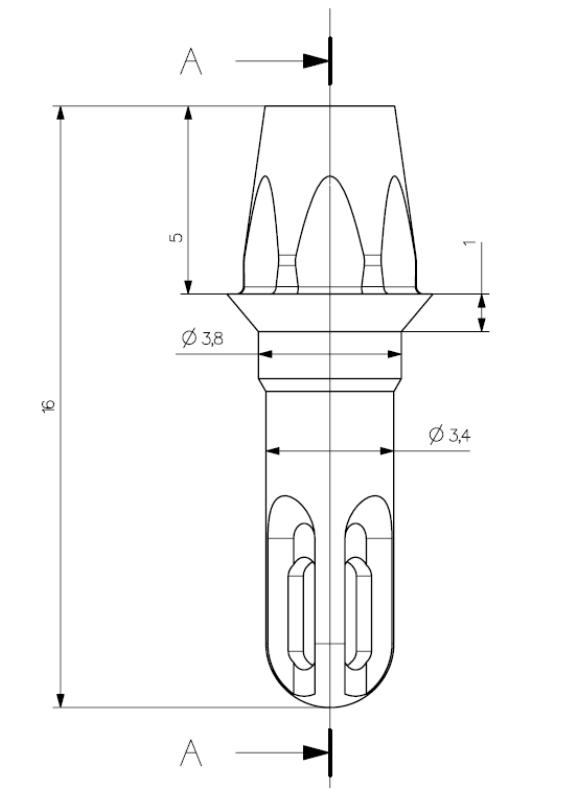
Figure 2. Documentation of the old external (EH) connection variant of the implant.The intraosseous part is the subject of a patent [7].